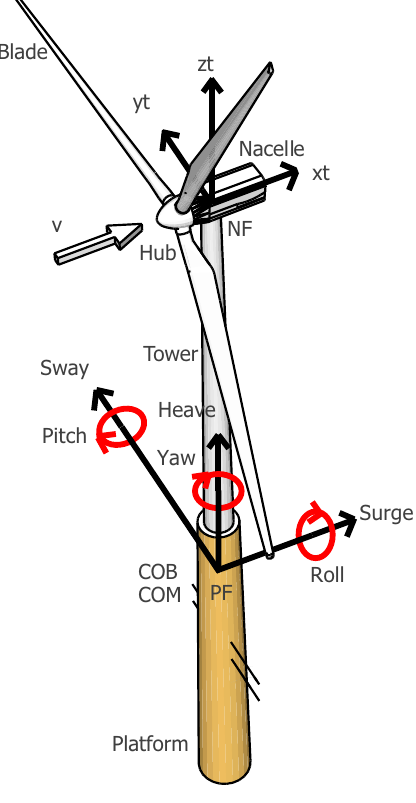
Figure 2.1: Floating wind turbine comprising a wind turbine mounted on a floating spar buoy platform (note mooring system is not